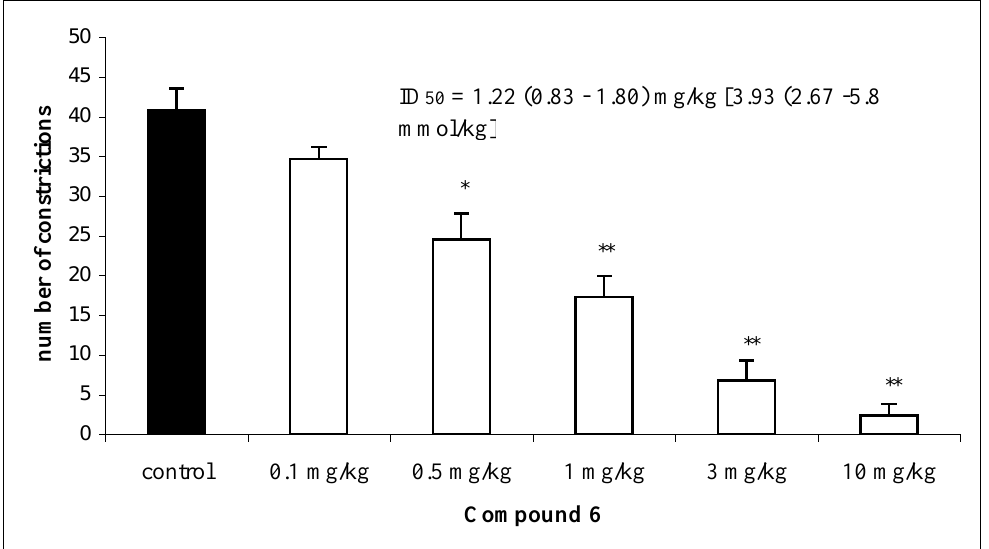
Figure 1. Effect of compound 6 (0.1, 0.5, 1, 3 and 10 mg/kg), given intraperitoneally, against acetic acid 0.6 % induced abdominal constrictions in mice. Each column represents the mean s.e.m. of six to eight experimental values. * p < 0.05; **p < 0.01.